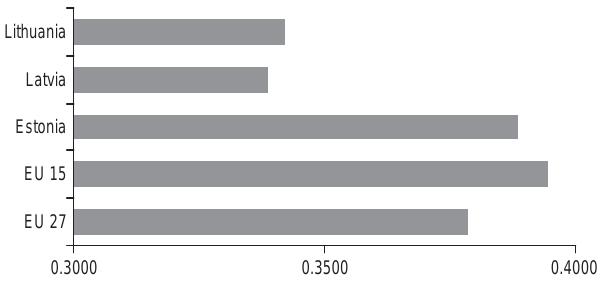
Fig. 5. Aggregated assessment of Baltic countries in the EU context during the averaged period of 2004–2008 (the third situation) Data source: Eurostat, Transparency international, The Heritage Foundation,